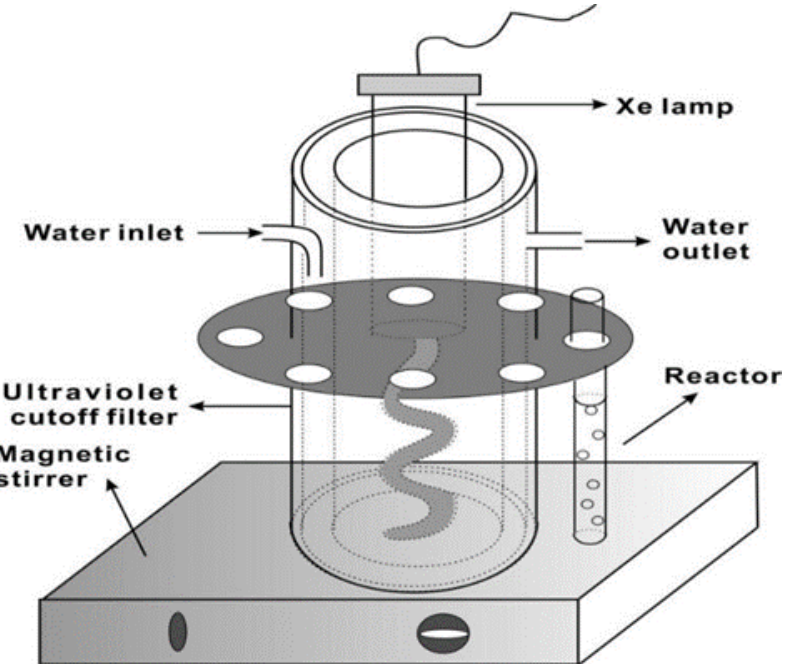
Figure 13 . Photocatalytic reaction device diagram . Figure 13. Photocatalytic reaction device